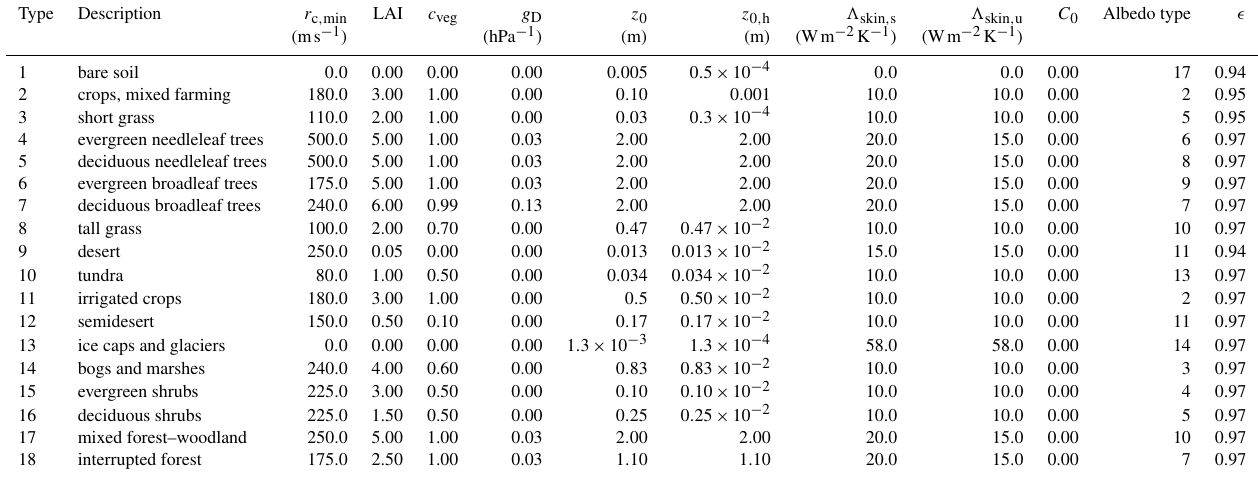
Table 1. Lookup table for vegetation parameters of 18 predefined vegetation types in the style of the ECMWF classification, adapted for PALM. (cid:51) skin , s and (cid:51) skin , u are the total thermal conductivities between the skin layer and the surface for near-surface stable and unstable stratification, respectively. (cid:15) is the surface emissivity. All other symbols are used as defined in the main